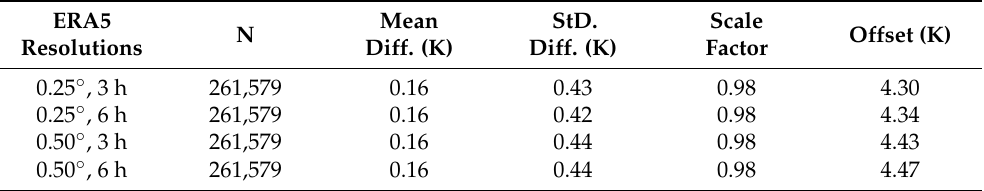
Table 4. Statistical parameters of the differences in SST skin derived from the Sentinel-3A SLSTR sensor and the ECMWF ERA5 atmospheric model (SST SLSTR –SST ERA5 ), for Sentinel-3A SRAL cycle